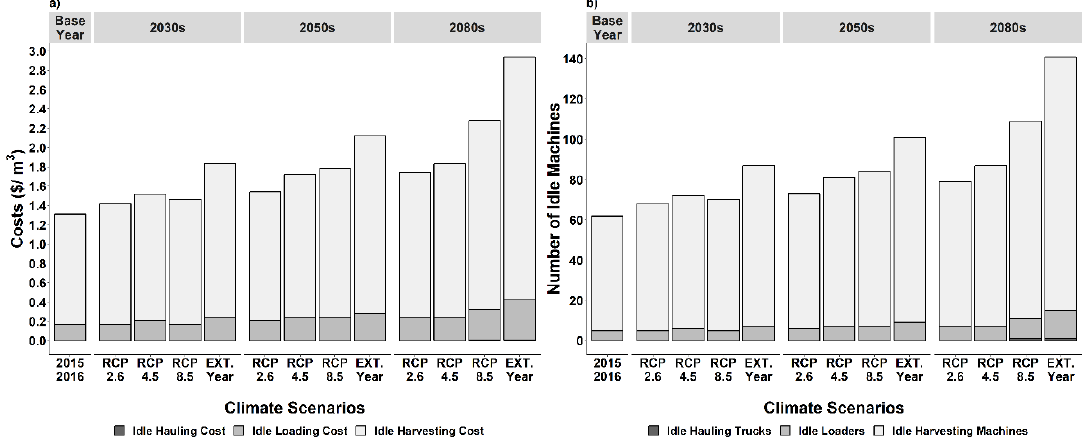
Figure 6. Analysis of idle logging equipment when logs were hauls both to the mill and satellite yards in the winter, under di ff erent climate scenarios in several di ff erent time in the future; ( a ) total unit cost of idle machines that are not operated in summer; ( b ) total number of machines that are idle in summer months. Sundays and holidays were subtracted from the available time for operations.